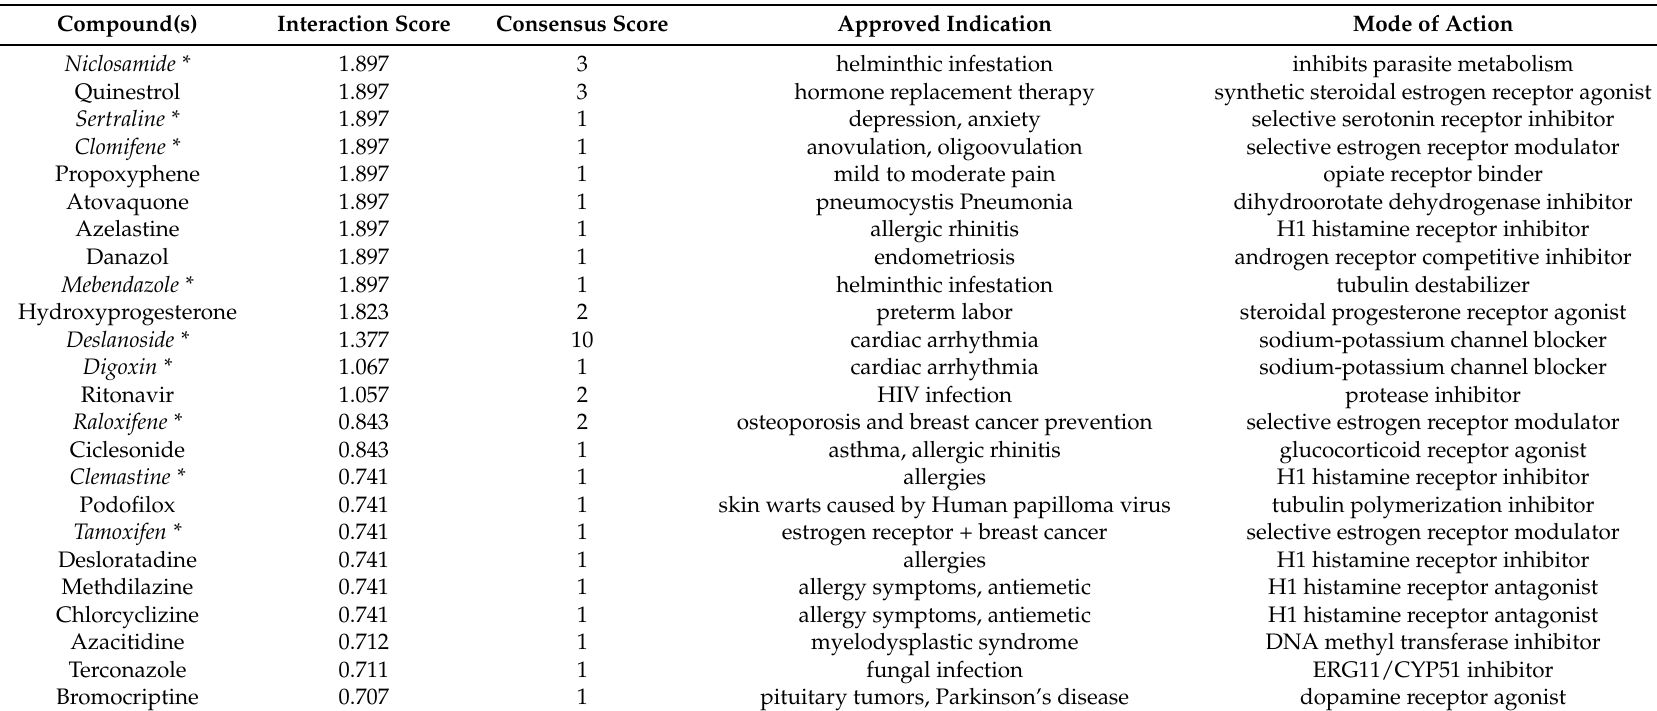
Table 3. Overlap between drug candidates generated by the CANDO platform and those identified by Johansen et al. [28] as FDA approved